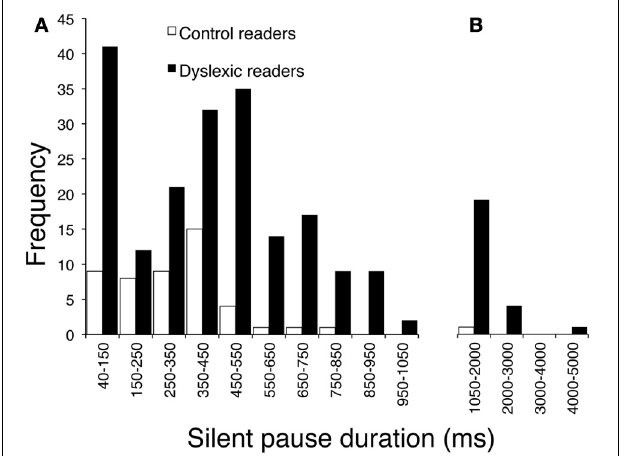
FIGURE 2 | Distribution of frequency for pause durations, separately for children with dyslexia and typically developing readers. (A) Intervals on the abscissa by 100ms each (except for the first one, which ranges from 40 to 150ms). (B) Intervals by 1000ms each.